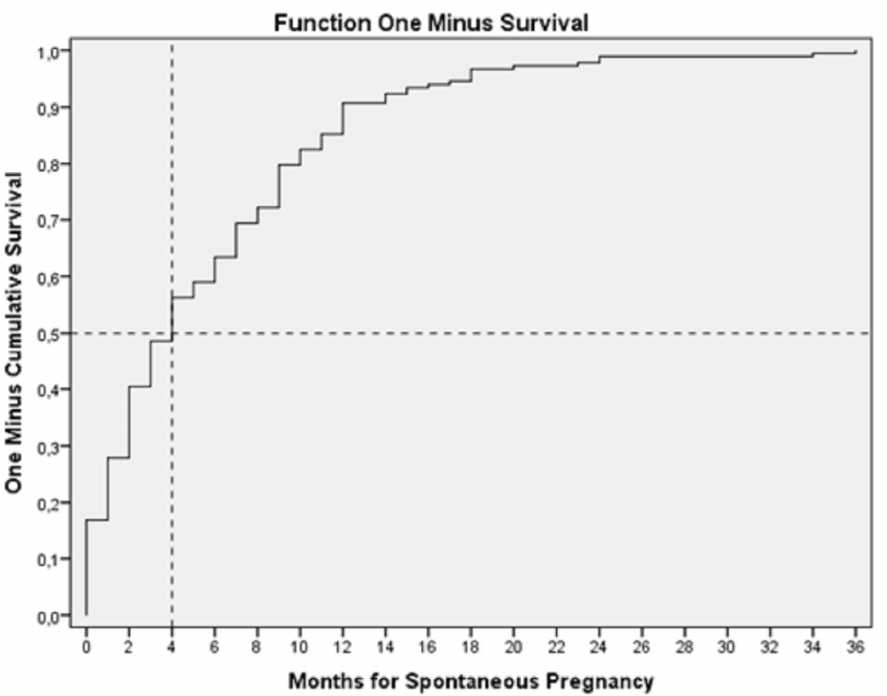
Figure 2. Kaplan-Meier graphic showing pregnancy rate after HyFoSy. Figure 2. Kaplan ‐ Meier graphic showing pregnancy rate after HyFoSy.